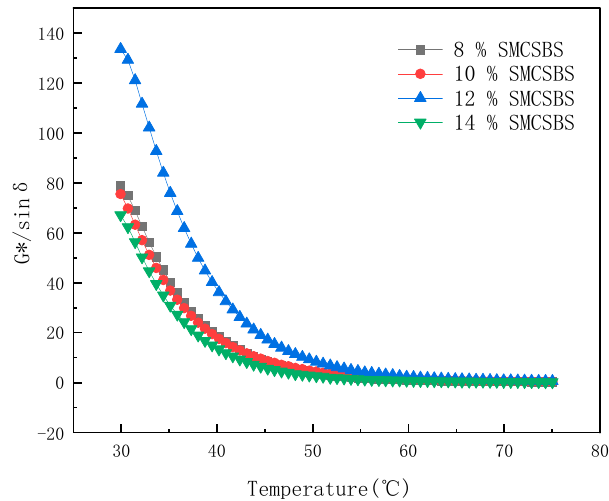
Figure 3. Variation curve of G*/sin δ of different SMCSBS content with temperature.